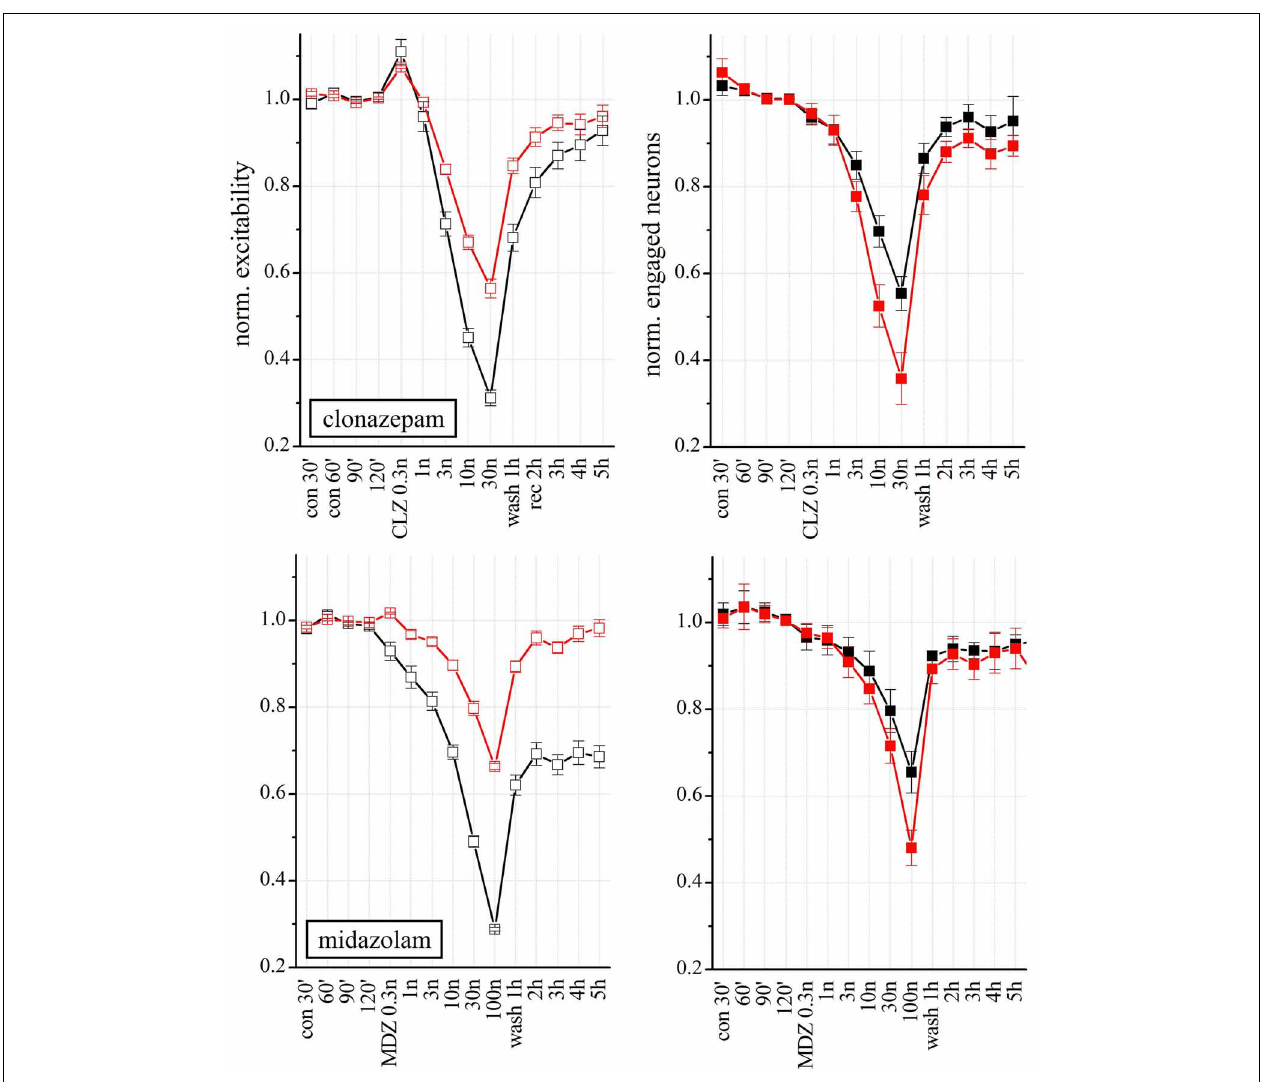
FIGURE 7 | Modulation of network activity by BDZs: differences in the effects of CLZ and MDZ. Upper : Plots of the normalized excitability of excitatory (red) and inhibitory (black) neuron clusters in control (30, 60, 90, and 120 min), after increasing concentrations of CLZ (left) or MDZ (right) and after wash-out (wash 1–5 h). Notice that MDZ after 5 h wash-out still maintained an effect on inhibitory clusters while CLZ did not. Moreover, to